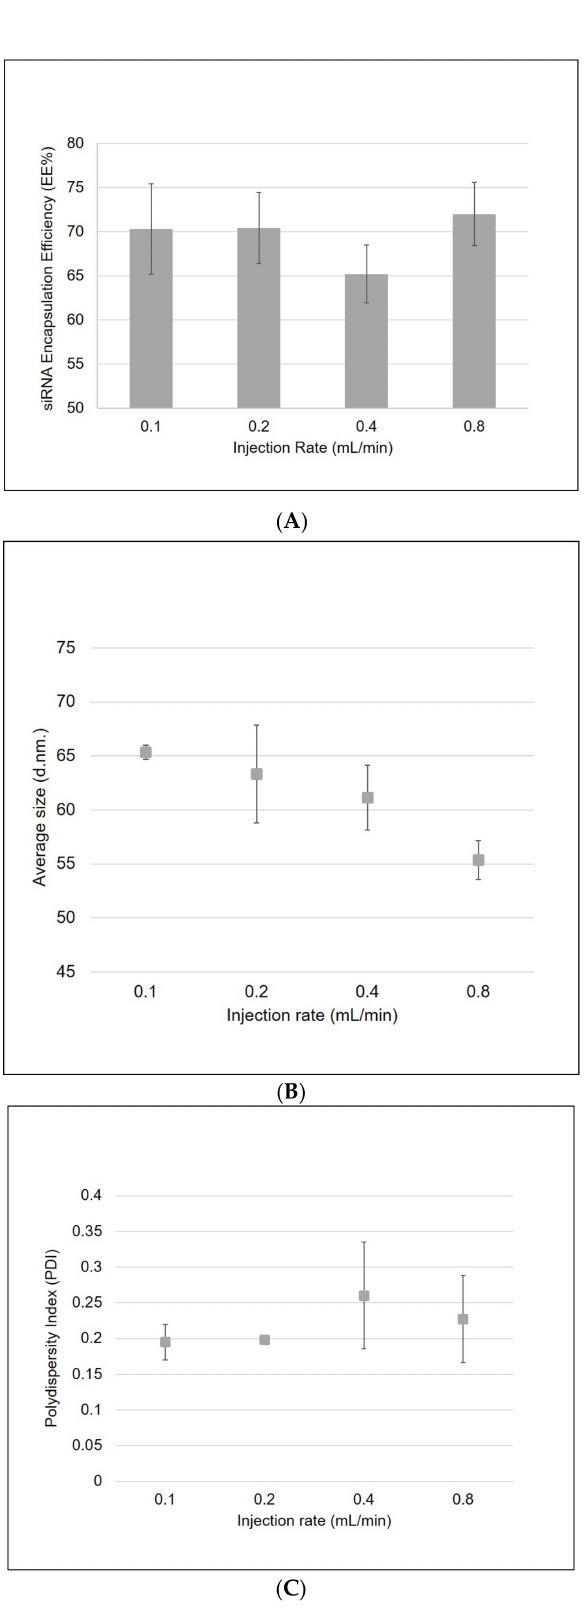
Figure 7. Slower injection rates during R8-PLP assembly ( A ) had no significant effect in siRNA EE%, but resulted in ( B ) increased mean diameter and ( C ) lower